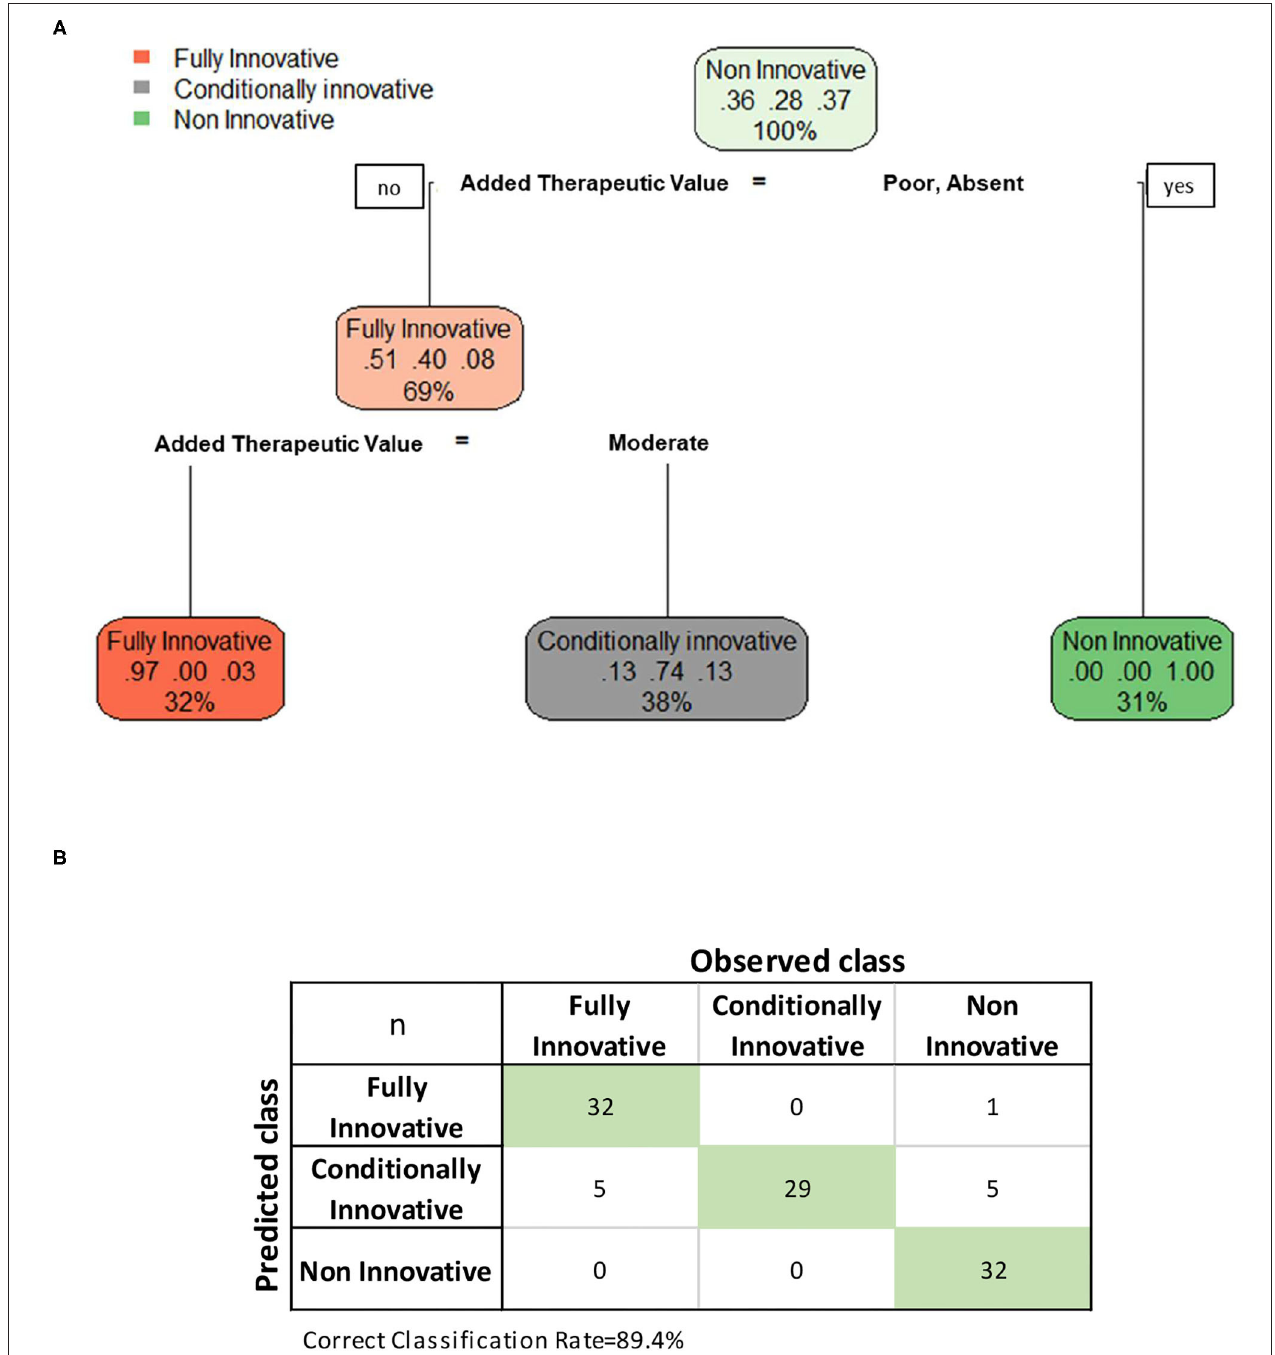
FIGURE 1 | (A) Illustration of classification tree built according to recursive partitioning (RPART) 3 model for the evaluation of drug’s innovation and (B) confusion matrix of the predicted vs observed classification responses for the complete sample without missing values ( n = 104). In each node are reported three main pieces of information: in the first line the name of the “most” frequent category of the outcome variable, in the second line the percentage for each category on the total amount of node observations, and in the third line the percentage of observations within the node on the total amount used in the model ( n = 104). For example, in the root node, the most frequent outcome’s category is “Non-innovative,” with a percentage of 37%. The root node contains the total amount of observations (100%) used in the model. While in the splitting node the most frequent outcome’s category is “Fully innovative” for 51% of nodes observations which contains 69% of the total amount of